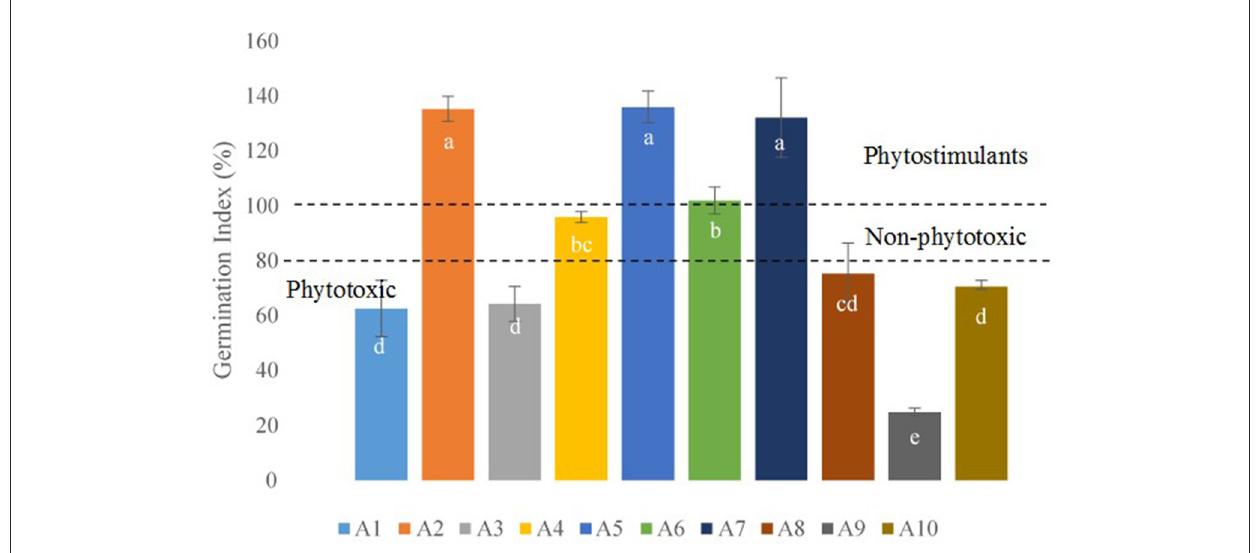
FIGURE2 Germination Index (%) derived from the application of actinobacteria with a sodium alginate matrix (0.5%) by biopriming on cucumber seeds. Bars indicate standard error. The letters inside the bars indicate different homogeneous groups with statistically significant differences (Fisher’s LSD test, P <